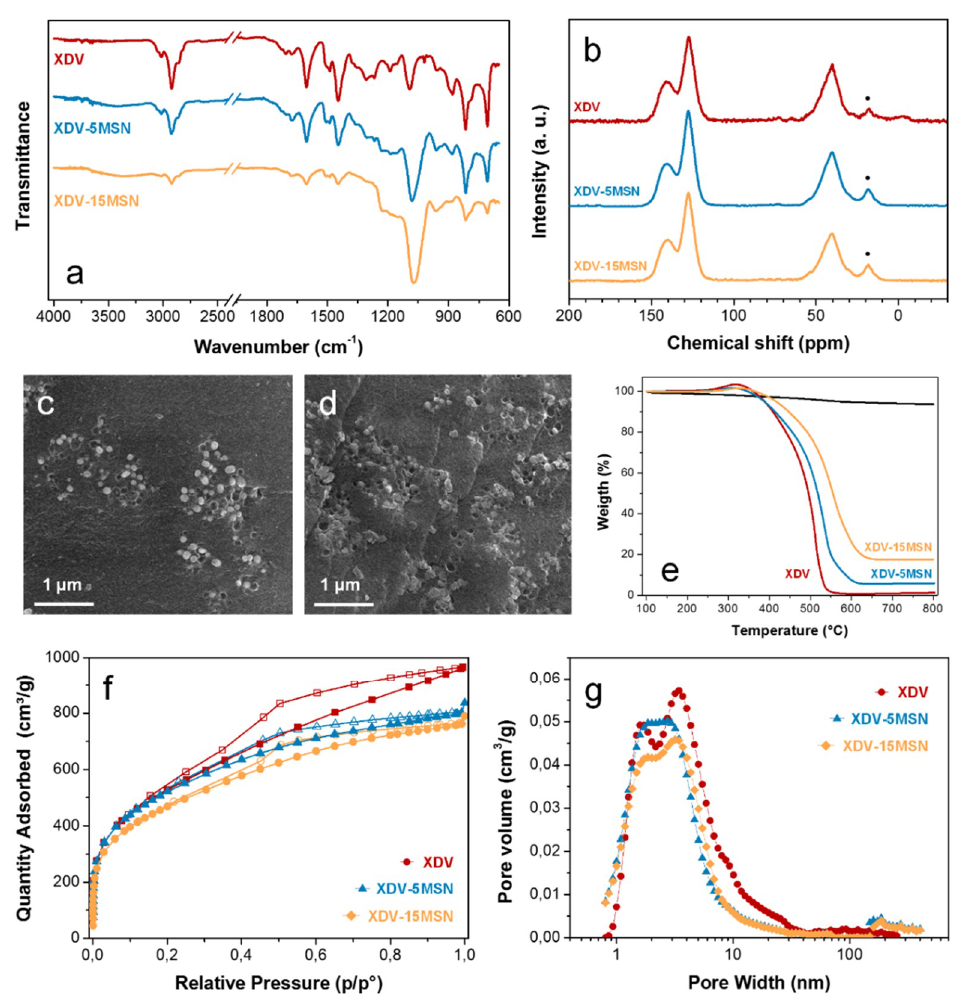
Figure 3. FTIR ( a ) and NMR ( b , spinning sidebands are marked by dots) spectra of XDV and XDV-xMSN, SEM images of XDV-5MSN and XDV-15MSN ( c , d ), TGA traces of XDV and XDV-xMSN ( e ), nitrogen adsorption (full symbols) and desorption (empty symbols) isotherms ( f ), and NLDFT pore size distribution ( g ) of XDV and XDV-xMSN. Table 1. BET SSA and porosity of hyper-crosslinked resins and nanocomposites. Sample BET SSA (m 2 / g) Total Pore Volume (cm 3 /